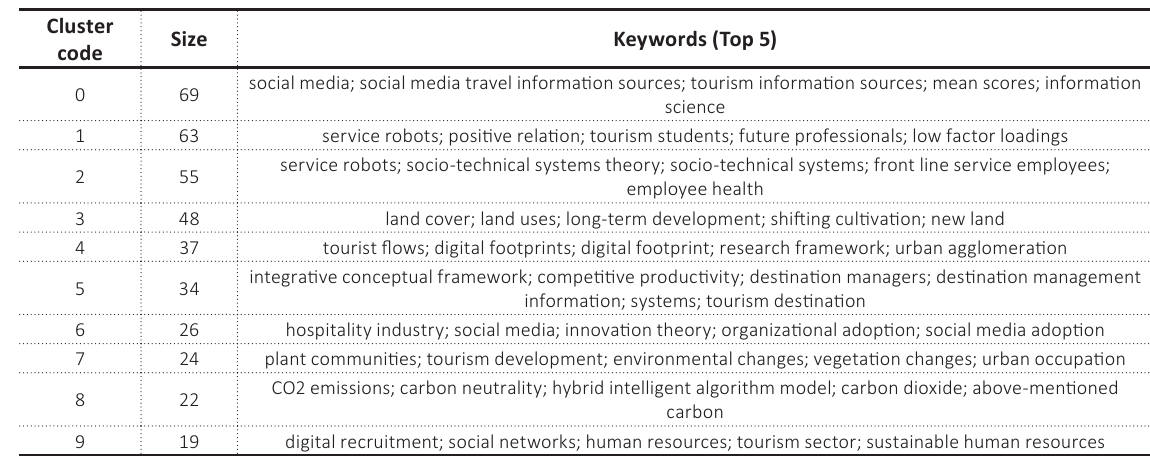
Source: Authors’ elaboration.